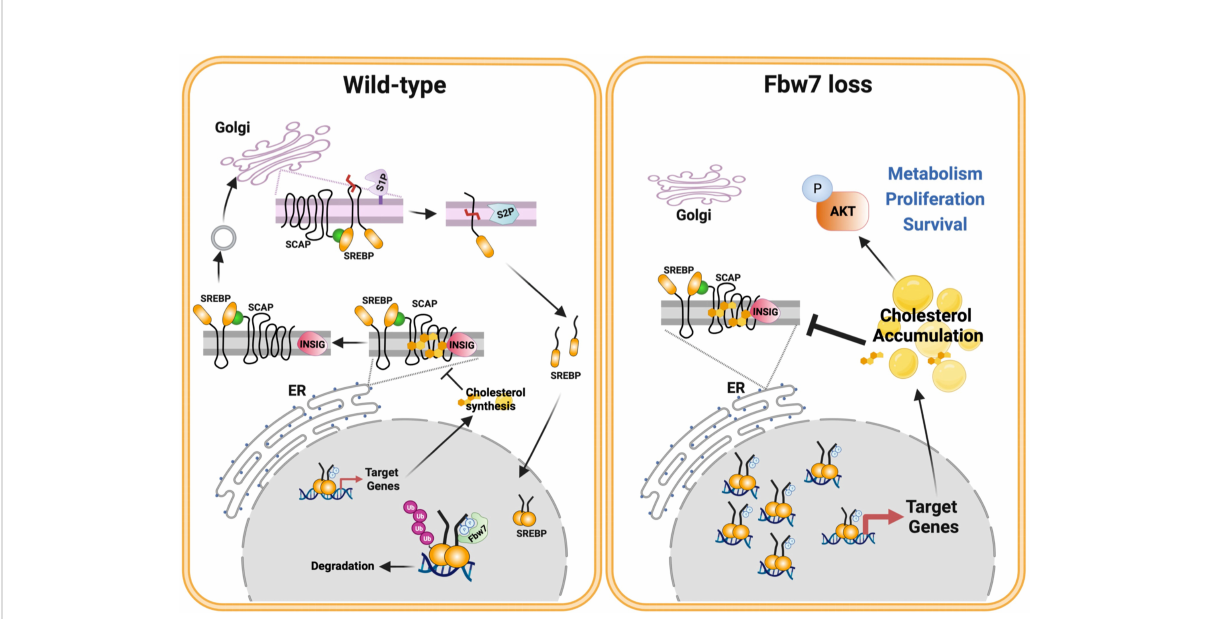
FIGURE 9 Fbw7 a loss in cancer cells rewires cholesterol metabolism resulting in activation of PI3K-AKT signaling. Based on the results of this investigation, we propose the following model. The activation of the SREBP family of transcription factors is controlled by the interaction between INSIG and SCAP and the SCAP-dependent transport of precursor SREBP molecules from the ER to the Golgi. Once in the Golgi, the precursor proteins are proteolytically cleaved by two separate proteases, site-1 protease (S1P) and S2P, thereby releasing the active transcription factors. The release of the SCAP-SREBP complex from the ER is inhibited by cholesterol. Under normal conditions ( left ), nuclear SREBP molecules are phosphorylated by GSK3 and targeted for ubiquitination and degradation by the tumor suppressor and E3 ligase Fbw7 a . This process ensures normal cholesterol homeostasis. However, this process is disrupted in response to loss of Fbw7 a protein and/or function ( right ). As a result, the levels of nuclear SREBP molecules accumulate and the expression of target genes is increased, including genes involved in cholesterol and fatty acid synthesis/ metabolism. Cancer cells express SREBP1a, the most potent transcriptional activator of the SREBP family, capable of activating both SREBP1 and SREBP2 target genes. As a result, loss of Fbw7 a in cancer cells results in a signi fi cant increase in both cholesterol and fatty acid synthesis.